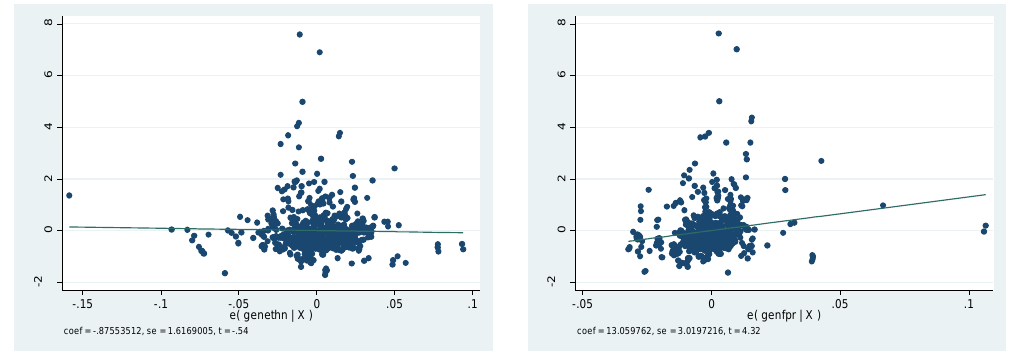
Figure A1. AV plots for outliers.